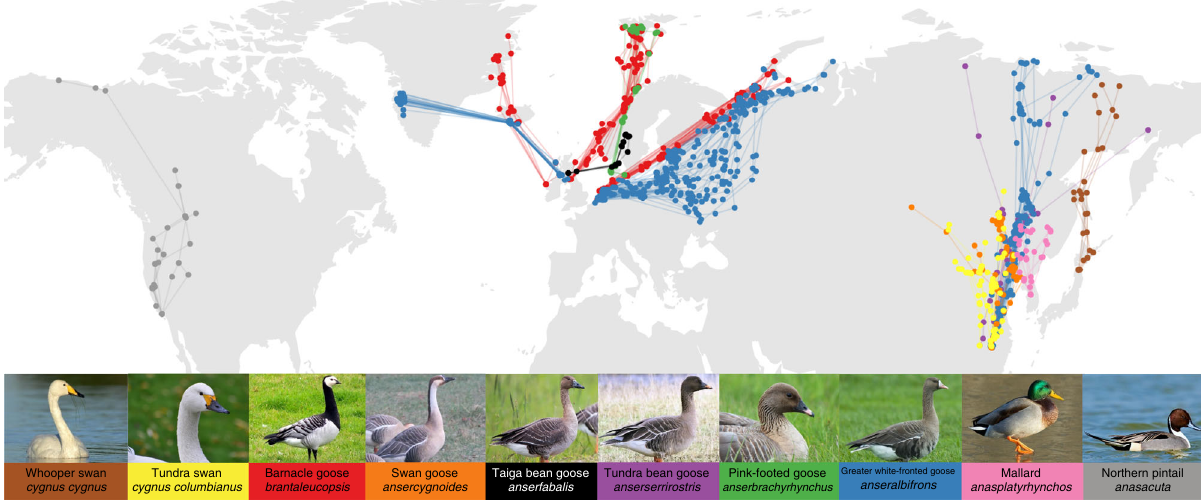
Fig. 1 Overview of spring migration and stopover site dataset for Anatidae. The dataset includes 222 spring migrations from 193 individuals belonging to 14 populations ( fi ve grazers, seven facultative herbivores and two omnivores) of 10 species covering Europe, East Asia and North America, from 1995 to 2016. Points are stopover site locations; point colour corresponds to background colour of species names; consecutive stopover sites during the individual migrations are connected by a line, as an indication of migration route. (Photo credits in order of appearance: J. Frade, M. Langthim, P. Ertl, Y. Muzika,